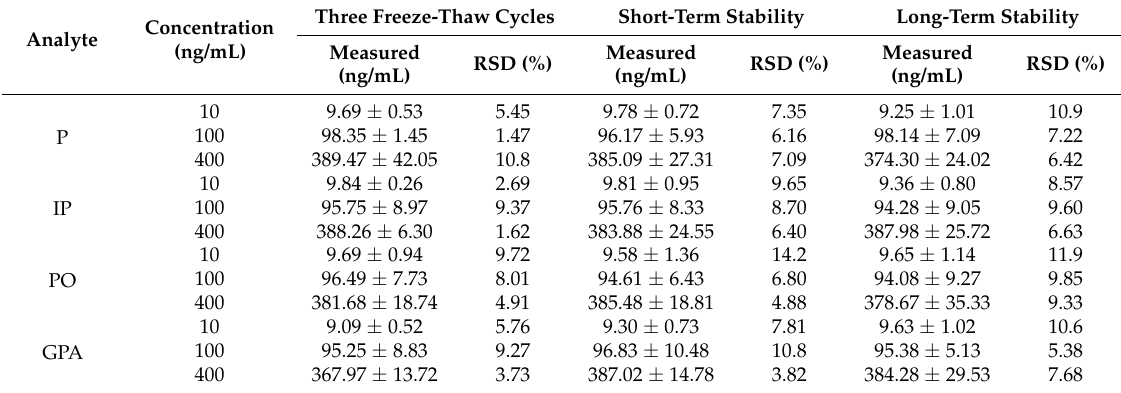
Table 3 Stability of four analytes in cell lysate.